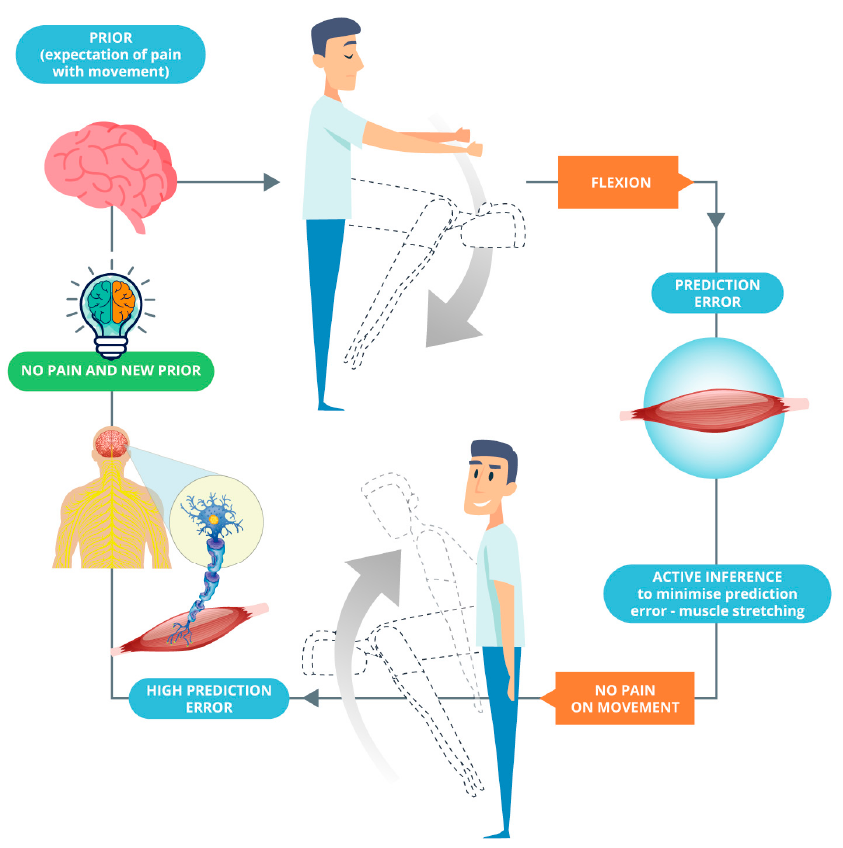
Figure 2. The expectation of pain (prior) is violated by feeling no pain during the movement, generating high prediction error and a new prior. This is argued to be the cycle established after a manual osteopathic treatment.